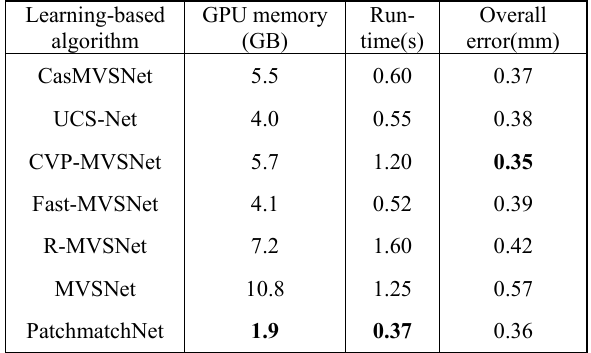
Table 1. Error comparison with learning-based MVS methods on GPU memory and runtime (source: Wang et al., 2020).